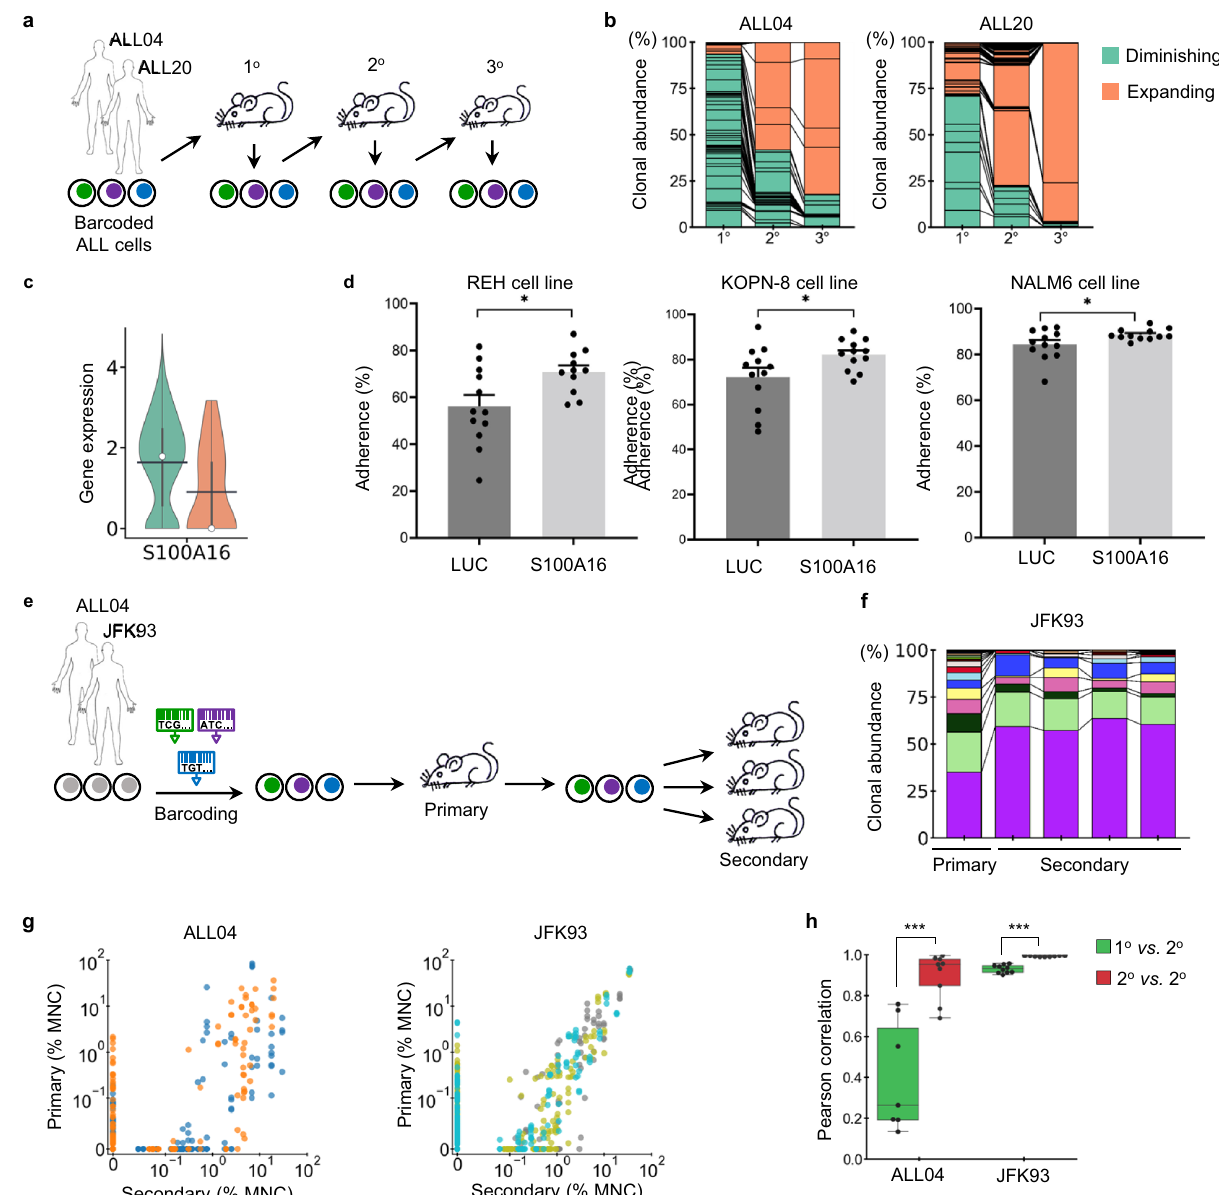
Fig. 3 Clonal selection occurs during serial transplantation. a Barcoded B-ALL cells were consecutively transplanted through three generations of mice. Clonal abundance was assessed in each recipient. b K-means clustering separated leukemia clones into diminishing and expanding groups. Each section in the column represents the average abundance of each clone from different mice. c Gene S100A16 was signi fi cantly differentially expressed between the diminishing and expanding ALL04 clones as classi fi ed in ( b ). Black bar indicates the mean, and white dot represents the median. d S100A16 and a negative control luciferase ( LUC ) gene were knocked out using the CRISPR/Cas9 technology in B-ALL cell lines (REH, KOPN-8, and NALM6). Adhesion of the B-ALL cells to OP9 stroma cells was analyzed after 48 h of co-incubation. Three independent experiments ( n = 11 for REH; n = 12 for KOPN-8 and NALM6). Data are shown as mean ± SEM. * P < 0.05, by two-sided t test without adjustment. e Human B-ALL cells were barcoded before primary transplantation and transplanted into multiple secondary recipients. f Clonal abundance changes during serial transplantation. Each color represents a genetic barcode corresponding to a leukemia clone. Each column shows data from one mouse. Additional mice are shown in Supplementary Fig. 14. g Clonal abundance comparison between the primary and secondary recipients during serial transplantation. Each dot represents a barcoded clone, and each color depicts one primary mouse. MNC mononuclear cells. h Pearson correlation of clonal abundance between different mice during serial transplantation. *** P < 0.001. Each dot represents a comparison between a pair of mice. Black lines in the boxes denote median values. Boxes extend from the 25th to the 75th percentile of each group ’ s distribution of values. P values were calculated by the two-sided t test without adjustment. All clonal abundance data in Fig. 3 originates from spleen cell analyses. Barcoded spleen cells were transplanted during serial transplantation. Source data are provided as a Source Data fi